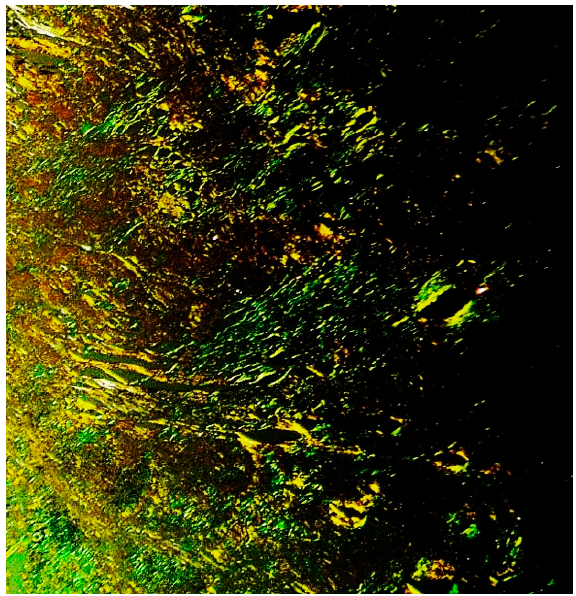
Figure 6. Cutaneous amyloidoma: typical green birefringence of the amorphous material (Congo red staining under polarized microscope, magnification 40×; original image from Prof. S.A.).